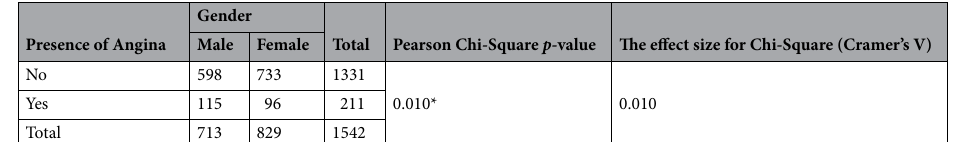
Presence of Angina